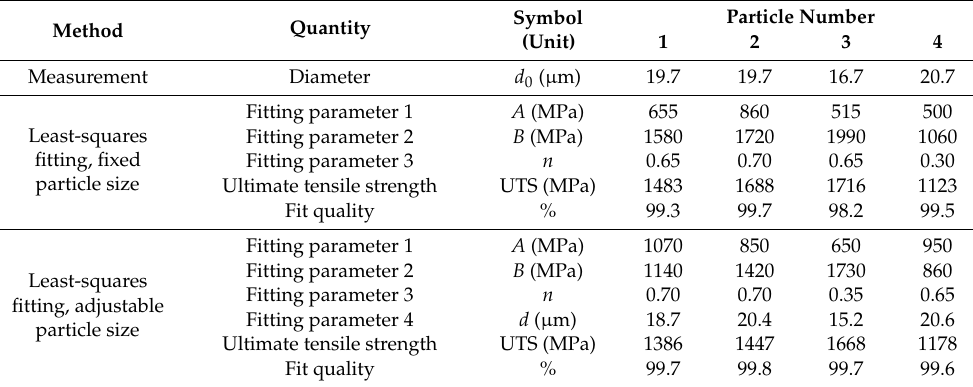
Figure 6. Selected results of the second fitting procedure, the particle size is taken as an adjustable fitting parameter, as applied to the same compression test data as shown in Figure 5, for Inconel 718 particles #1–4 (Table 1). The dotted lines are the converted measured data and the solid lines (50% transparent, red in the colour version) are the fitting curves. Table 2. Examples of fitting parameters and the estimated ultimate tensile strength (UTS) for particles #1–4, as obtained from the two di ff erent fitting